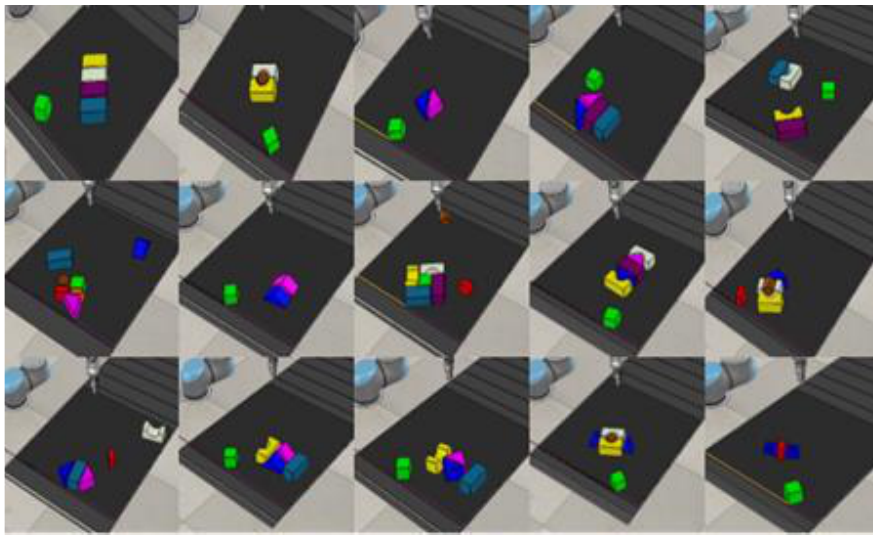
Figure 17. Complicated scenarios comprising 3 to 7 regular and irregular objects, designed for testing.